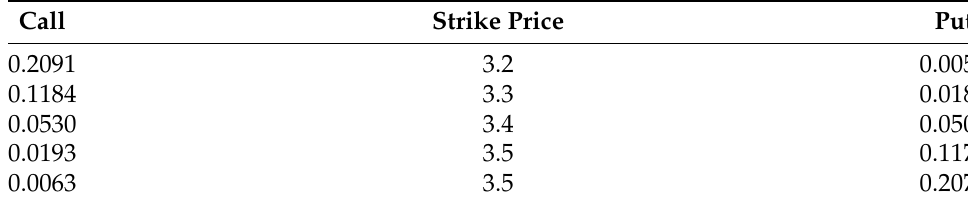
Table 1. 50 ETF option quotation.